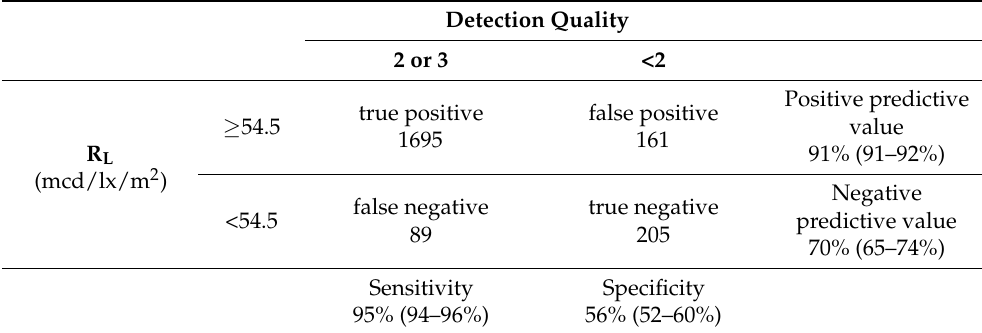
Figure 2. ROC curve of R L for differentiation of detection quality below 2, 2 or more. Table 6. Diagnostic value of determined R L cut-off point of 54.5 mcd/lx/m 2 for a minimum of level 2 detection